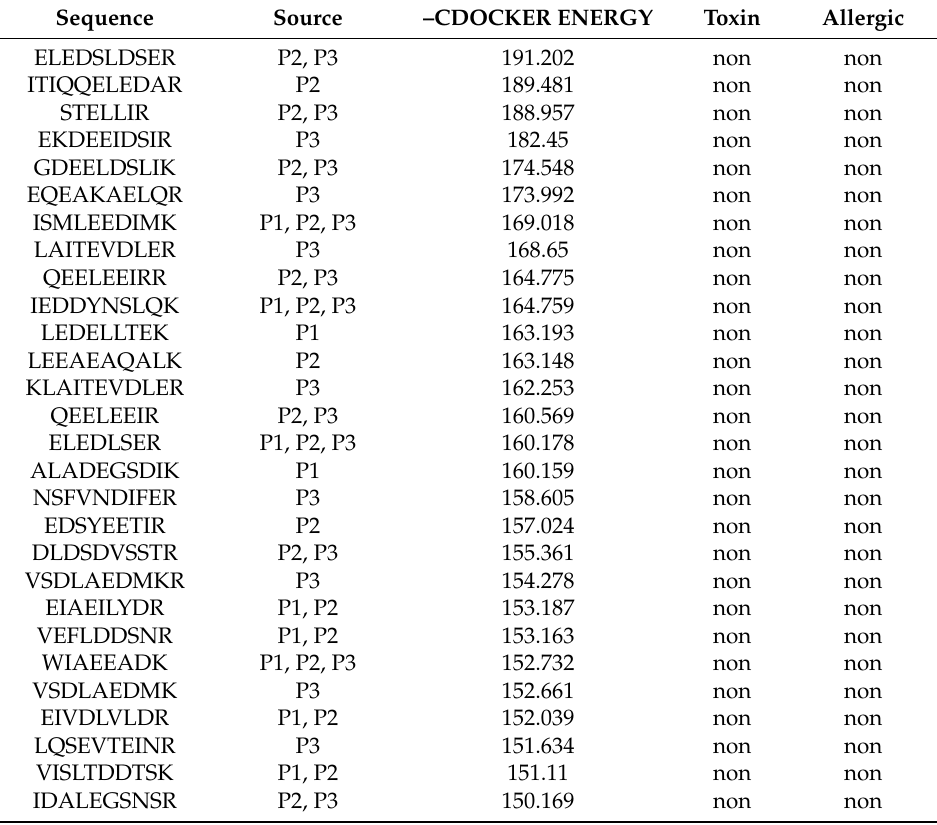
Table 1. Peptides in enzymatic hydrolysates of P1–P3 M. edulis protein